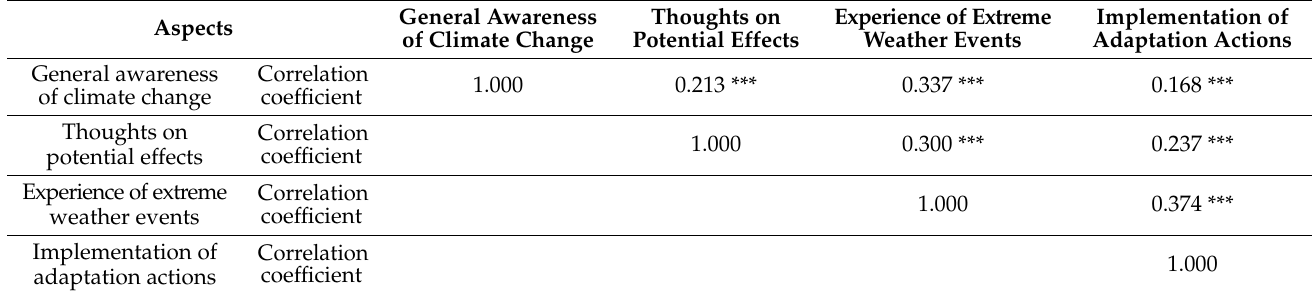
Table 8. Results of Spearman’s correlation analysis on the four